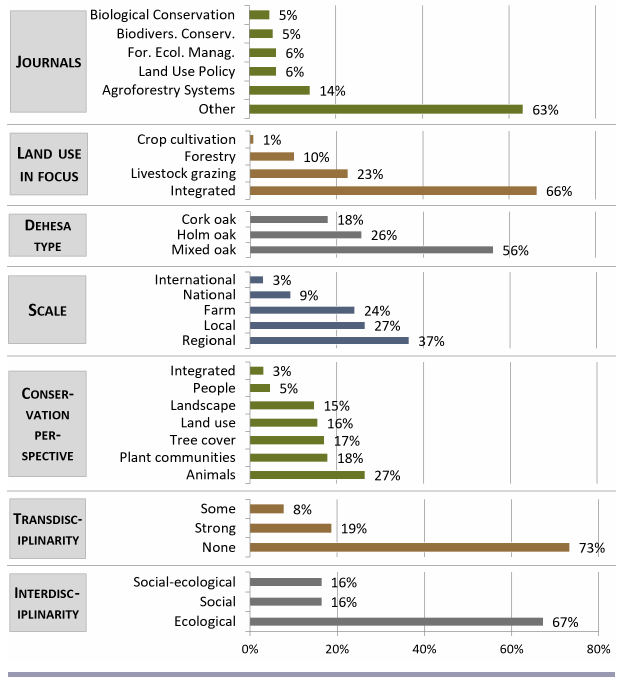
Fig. 5 . Percentage of studies following different analytical approaches.